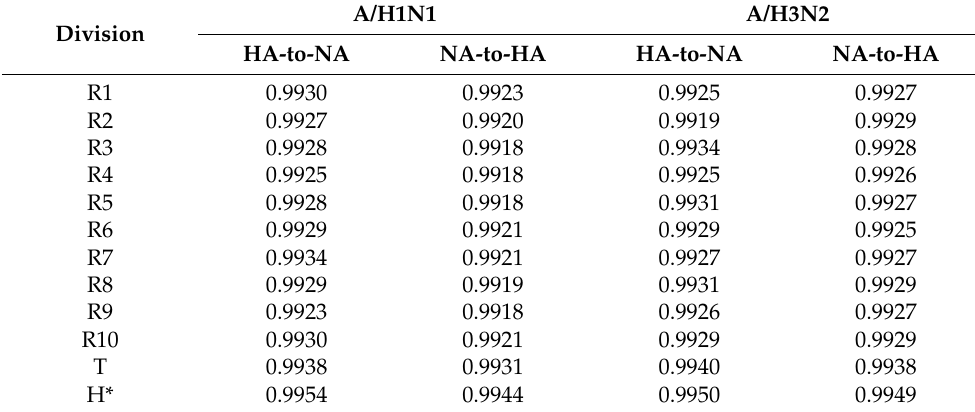
Table 2. Testing accuracies of S2STM.